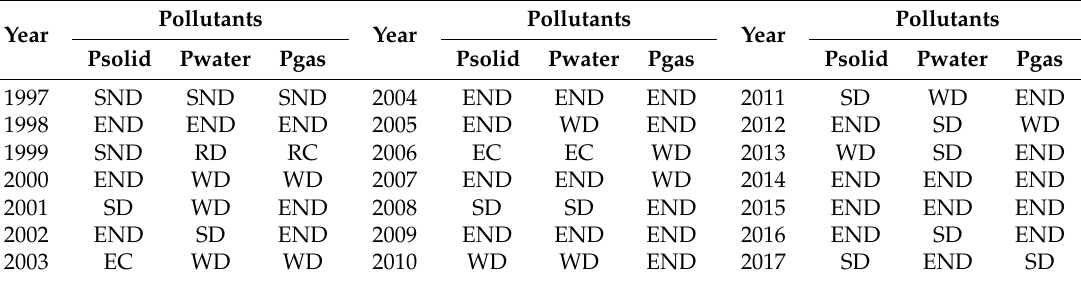
Table 2. The decoupling states in Yulin City during